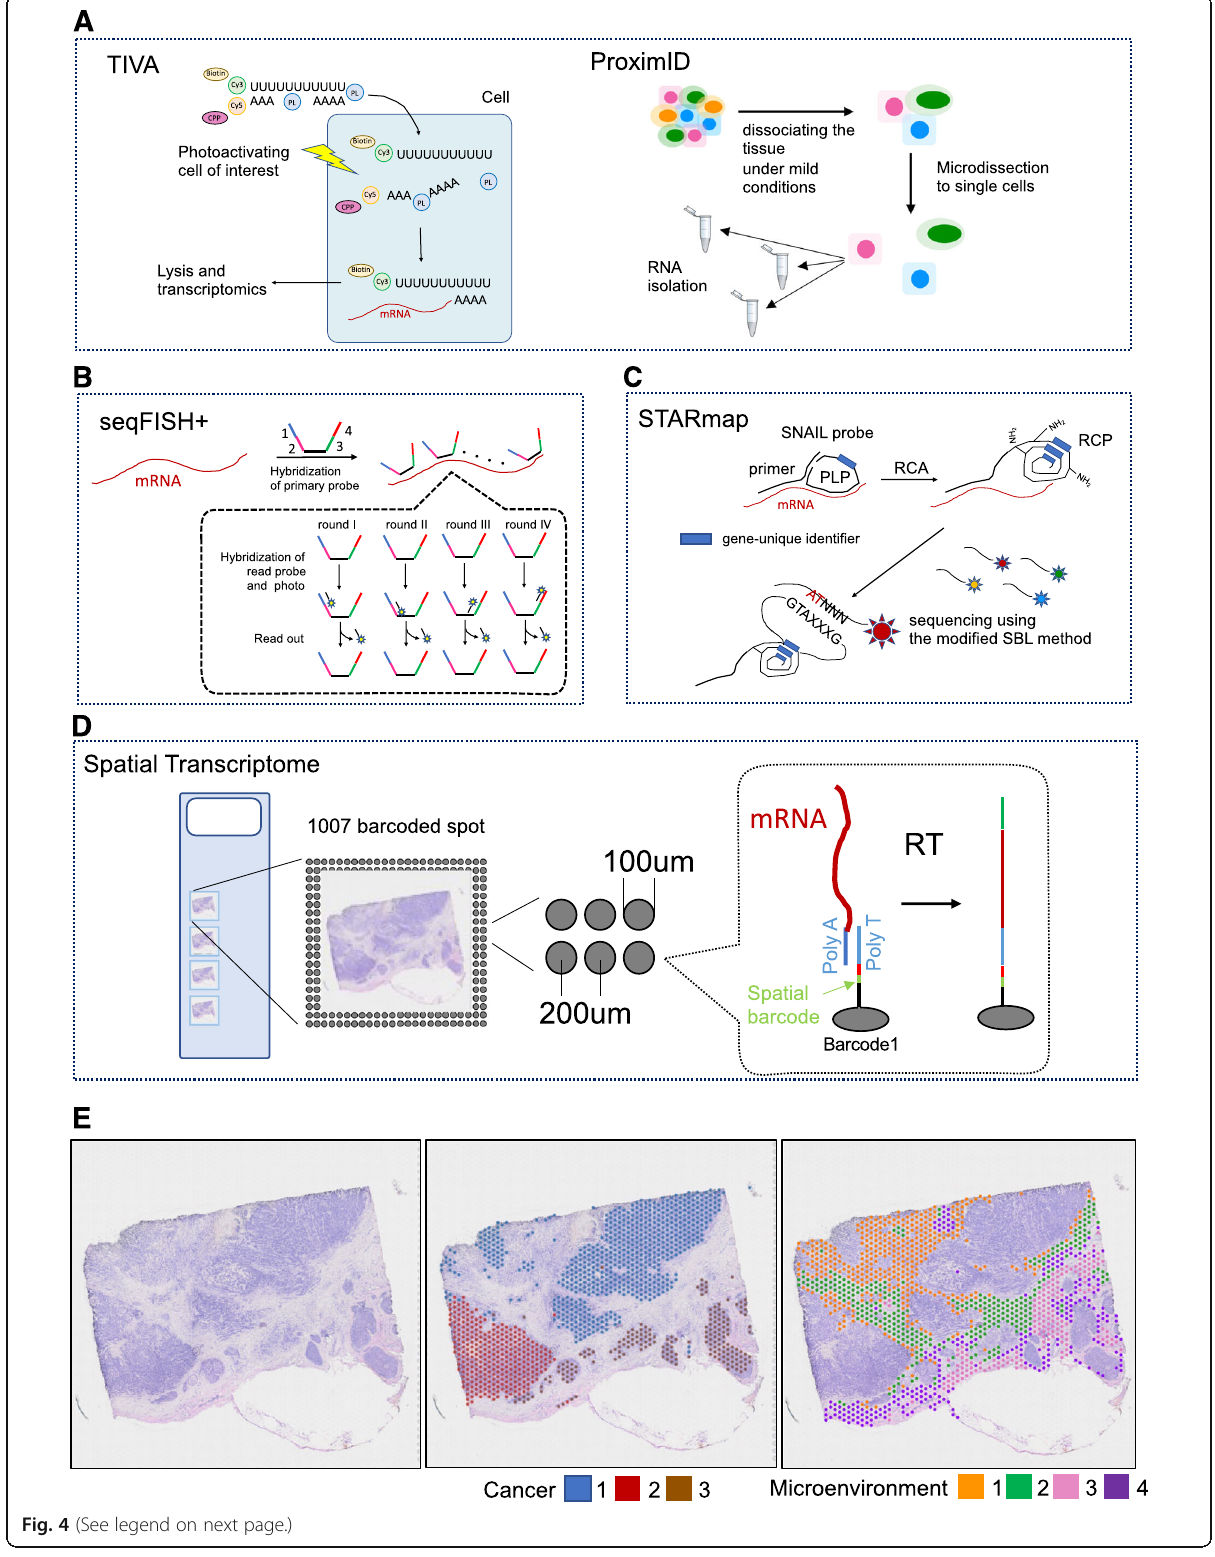
Fig. 4 (See legend on next